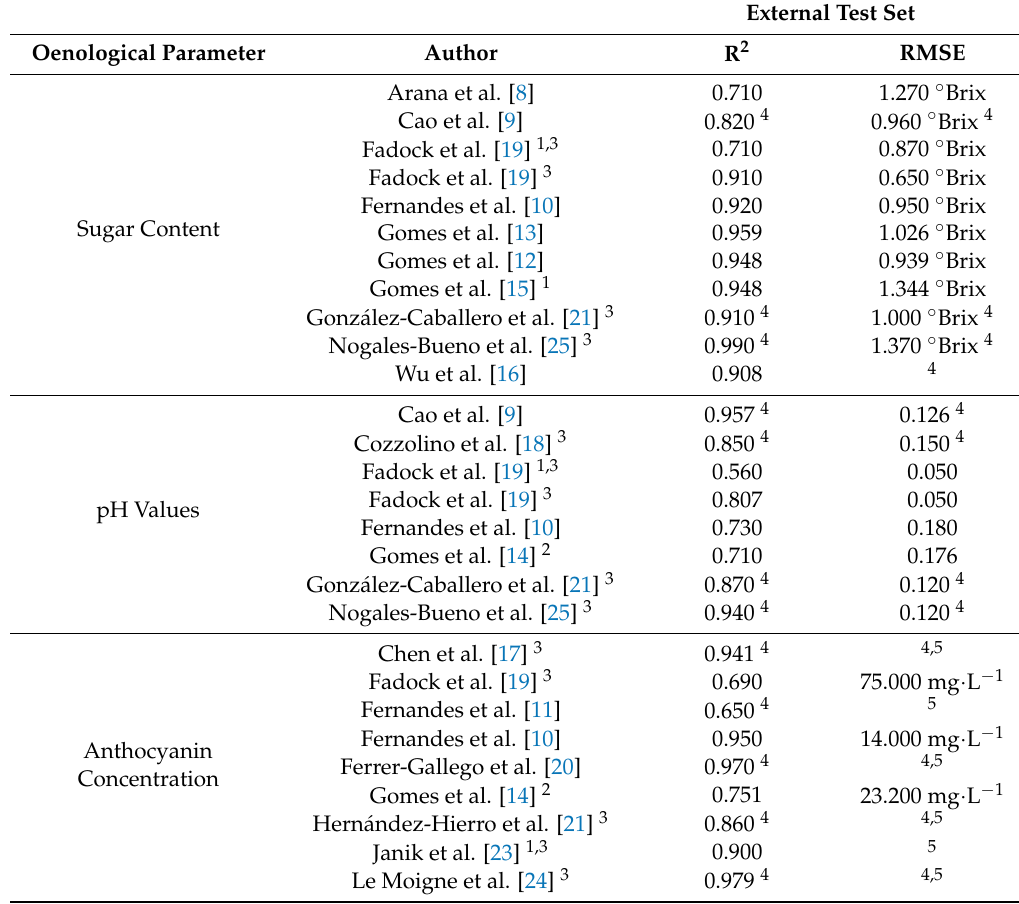
Table 1. Literature results for the prediction of the oenological parameters for whole wine grape berries with hyperspectral imaging performed in reflectance